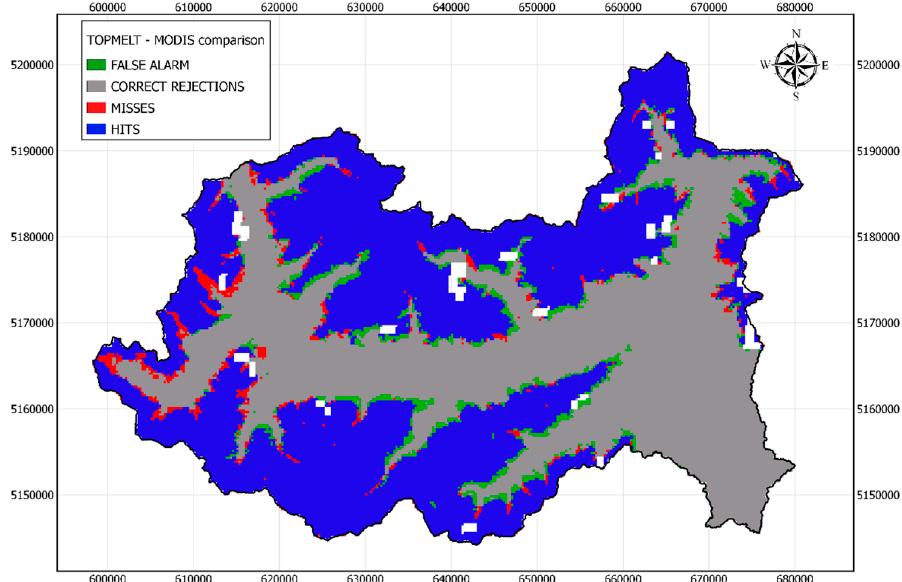
Figure 3. Comparison between TOPMELT and moderate resolution imaging spectroradiometry (MODIS)-based snow-covered area (SCA) on 25 April 2013 in terms of contingency table outcomes. Blank pixels are cloudy pixels according to MODIS classification on the reference day.